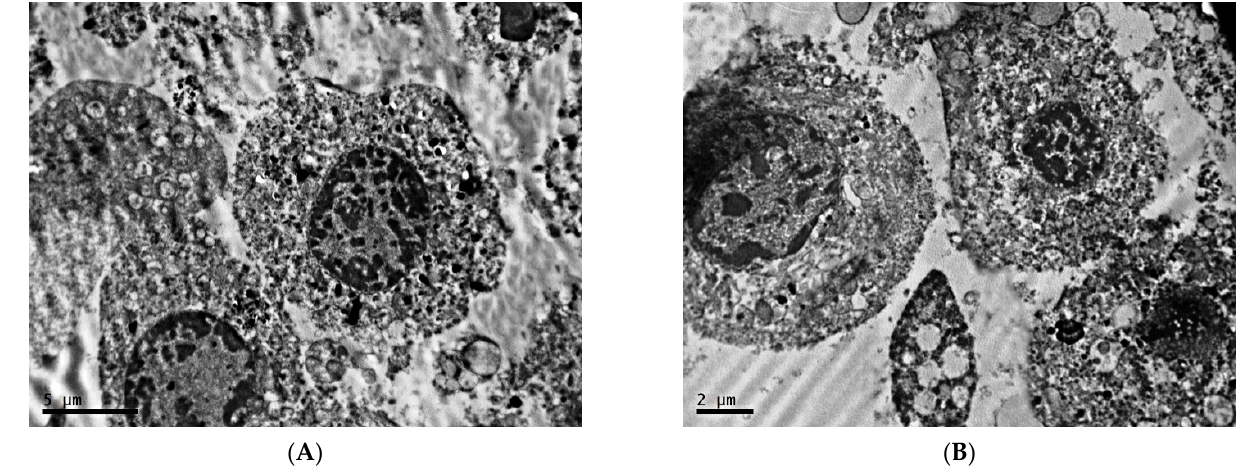
Figure 6. Morphological condition of tissue of transplantable malignant melanoma B16 under the influence of constant lighting. TEM, ( A , B )—×6700.